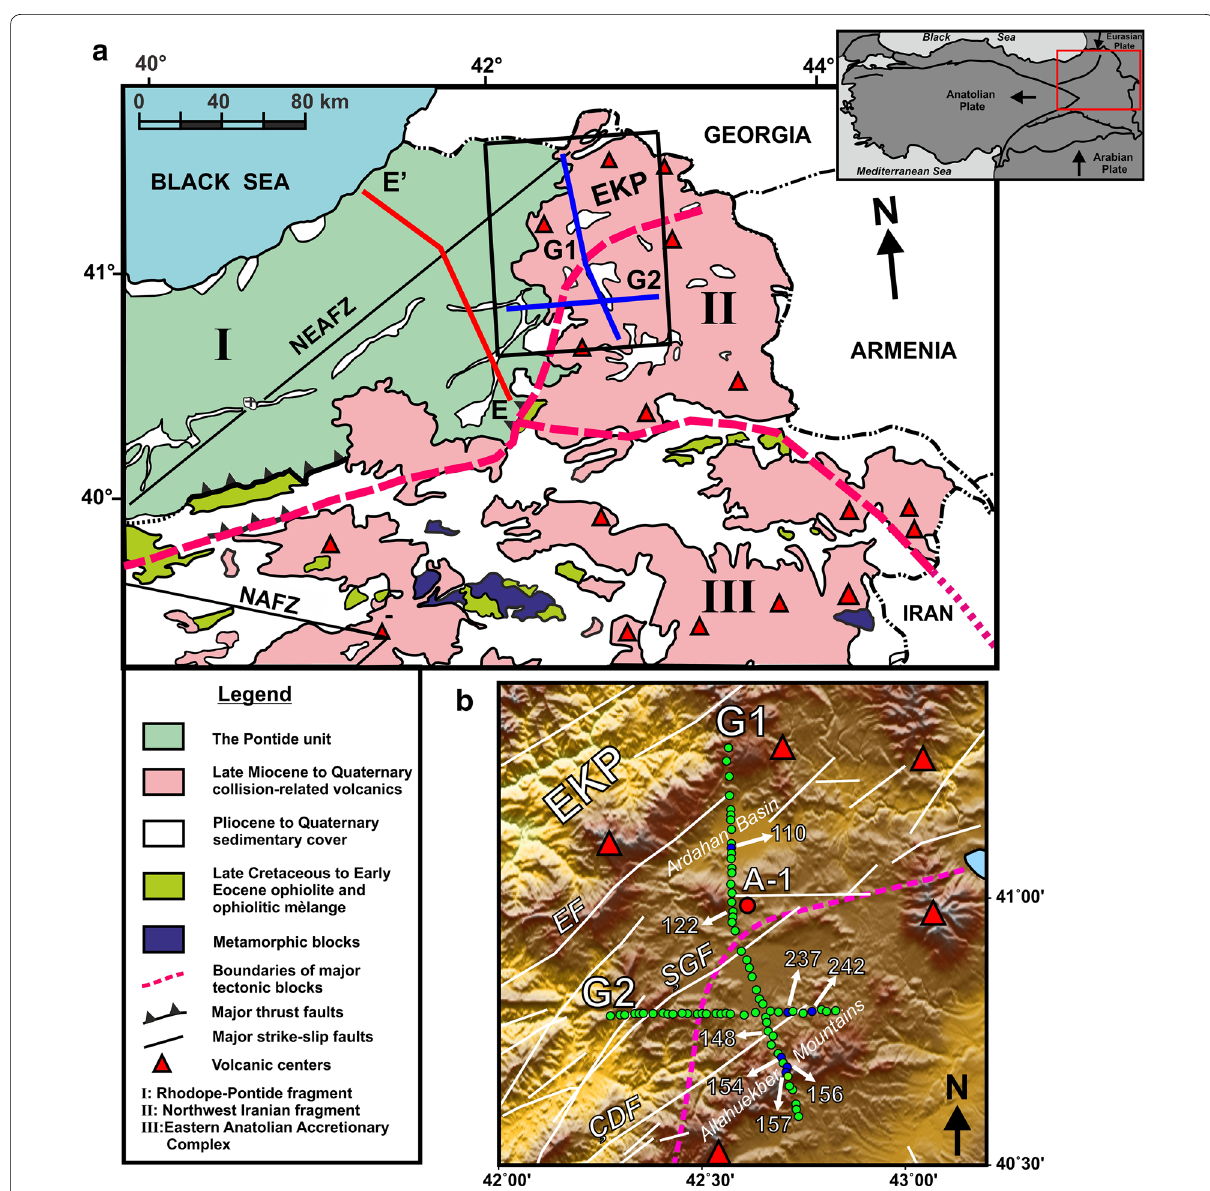
Fig. 1 a Simplified geological map and tectonic blocks (modified from Şengör et al. 2003; Keskin et al. 2006; Keskin 2005) showing the study area (black rectangular box) with MT profiles (blue solid lines, G1 and G2). Red solid line (E ′ -E) denotes approximate location of the MT profile from previous study by Türko ğ lu et al. (2008). b Topographic map of Erzurum–Kars Plateau superposed with fault branches (white solid lines). Yellow dots show the location of MT sites. Blue dots show the location of MT sites distorted by static shift. Red dot indicates position of the borehole (A-1). EKP: Erzurum–Kars plateau, NEAFZ: Northeast Anatolian fault zone, NAFZ: North Anatolian fault zone, ÇDF: Çobandede fault, EF: Erzurum fault, ŞGF: Şenkaya–Göle